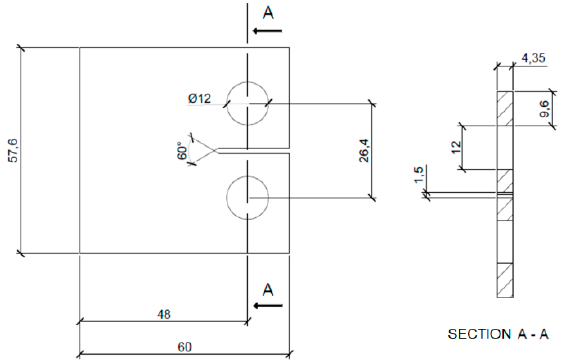
Figure 6. Compact Tension (CT) specimen scheme and dimensions for the Mode I FCGR experiment (puddle iron, all dimensions in mm).